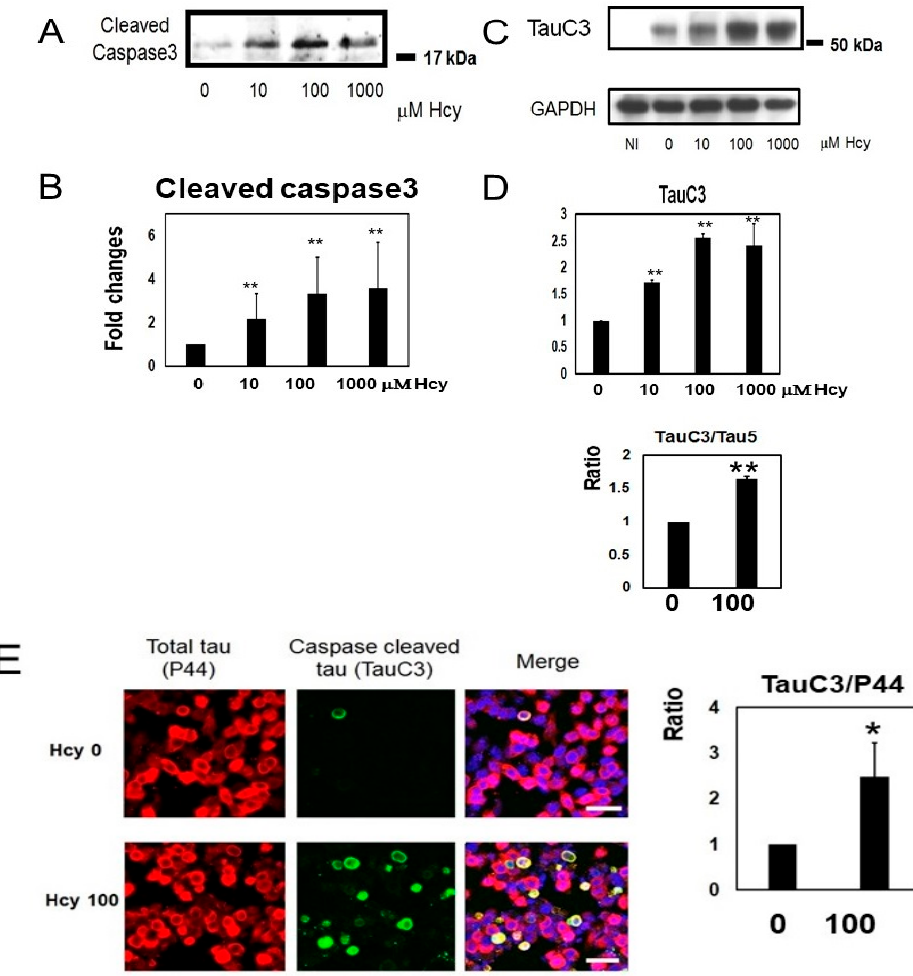
Figure 5. Homocysteine (Hcy) activated caspase 3 and increased caspase-cleaved tau at the C-terminus in M1C cells. Hcy treatment upregulated caspase 3 levels ( A , B ). Hcy increases caspase cleavage of tau. TauC3-positive caspase-cleaved tau was increased in a dose-dependent manner when cells were exposed to L-Hcy. The ratio of TauC3 to Tau5 (total tau) was increased by Hcy. Bar: ± SD, * p < 0.05, ** p < 0.01 ( C , D ). Immunocytochemical study demonstrated that homocysteine treatment increased caspase-cleaved tau species. Antibody P44 recognizes the total tau. Treatment of cells with 100 µM Hcy caused a slight increase of Tau5 positive cells. However, TauC3-positive cells markedly increased when cells treated with 100 µM Hcy. The ratio of TauC3 to P44 (total tau) was increased following Hcy treatment. 0: 0 µ M Hcy, 100: 100 µ M Hcy, Scale: 75 µ m ( E